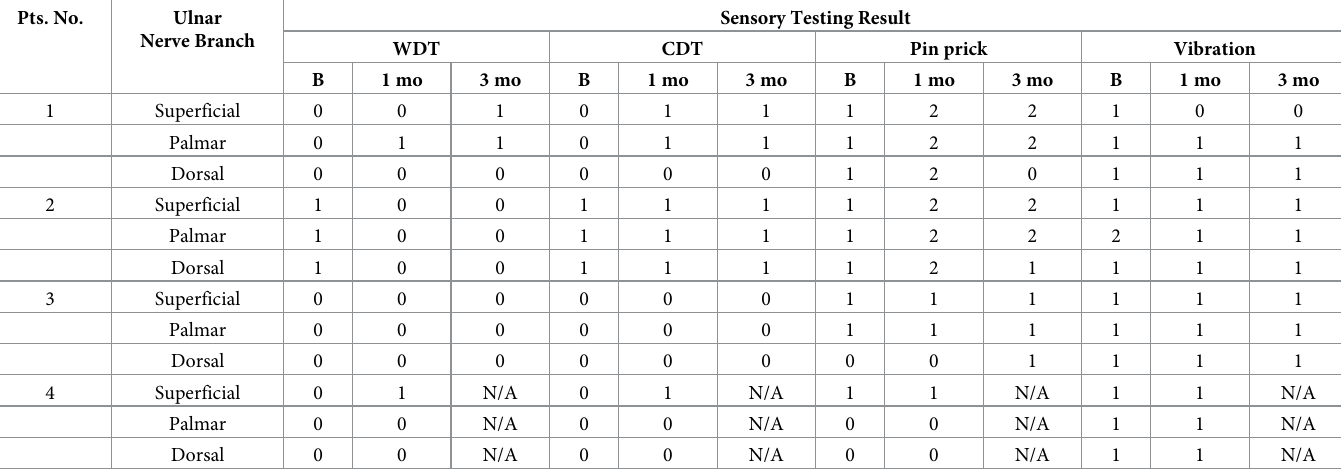
Table 2. Sensory testing for Warm Detection Threshold, Cold Detection Threshold, Pin prick test and Vibration test. Pts.